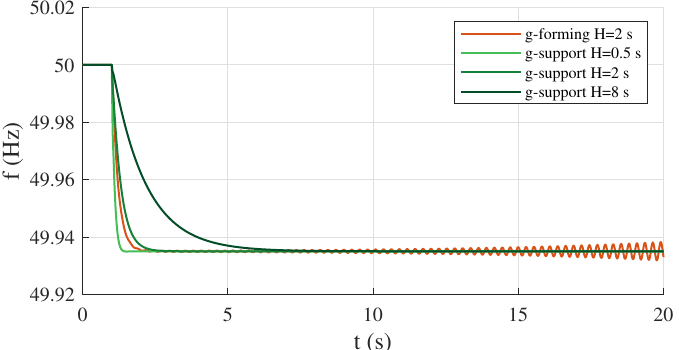
Figure 13. Contribution of grid-supporting controls with two grid-forming converters.